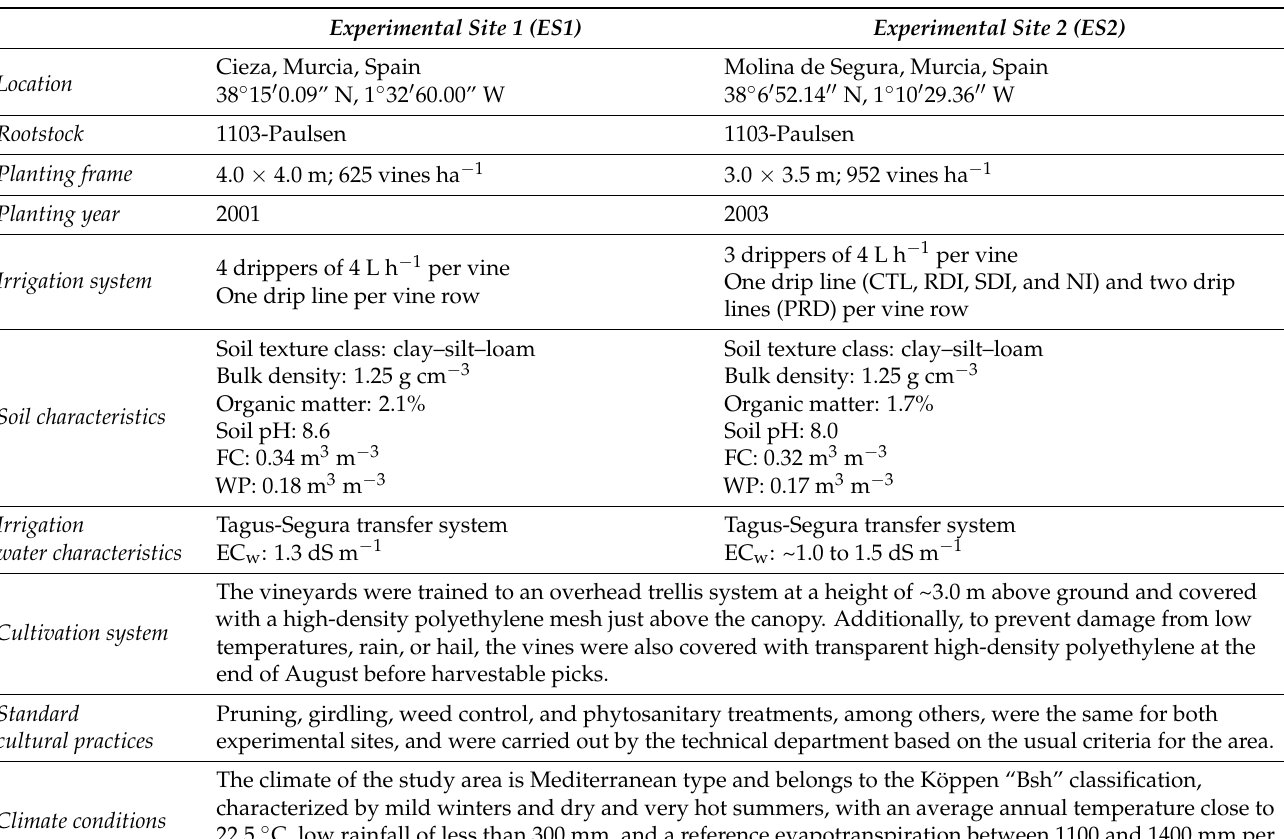
Table 1. Description of table grape cv. Crimson Seedless experimental sites for data acquisition [19,21,43]. Experimental Site 1